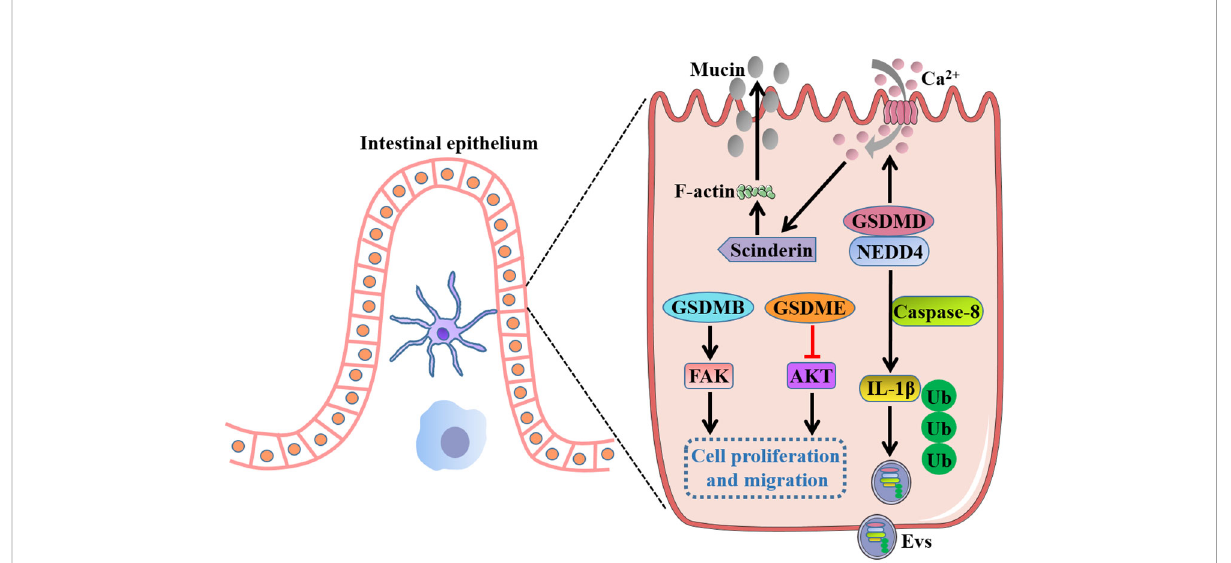
FIGURE 5 Intrinsic functions of GSDMs in gut independent of pyroptosis. Full-length GSDMB promotes cell proliferation and migration by regulation of FAK, whereas full-length GSDME suppresses cell growth by negative regulation of AKT pathway. GSDMD drives mucin secretion through calcium ion in fl ux-dependent scinderin-mediated cortical F-actin disassembly, and recruits NEDD4 to mediate the release of polyubiquitinated IL-1 b in the form of Evs via a caspase-8-dependent manner. FAK, focal adhesion kinase; NEDD4, an E3 ligase; Evs, extracellular